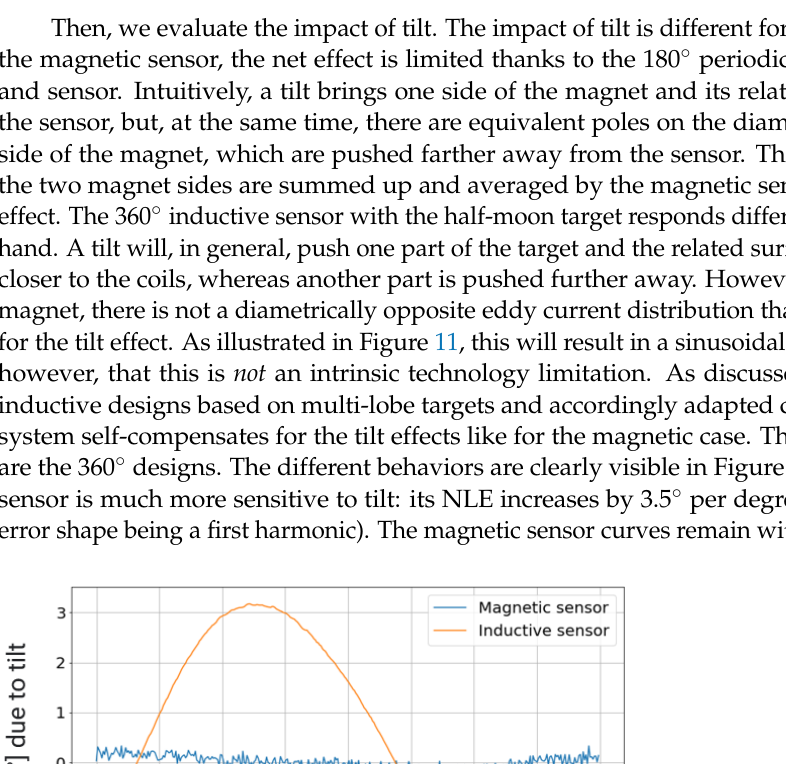
Figure 10. Angle error curves due to a 1 mm airgap shift. The inset depicts the configuration. The dotted green line is the center line through the sensor and target centers (which remain aligned in this test). The impact is modest.